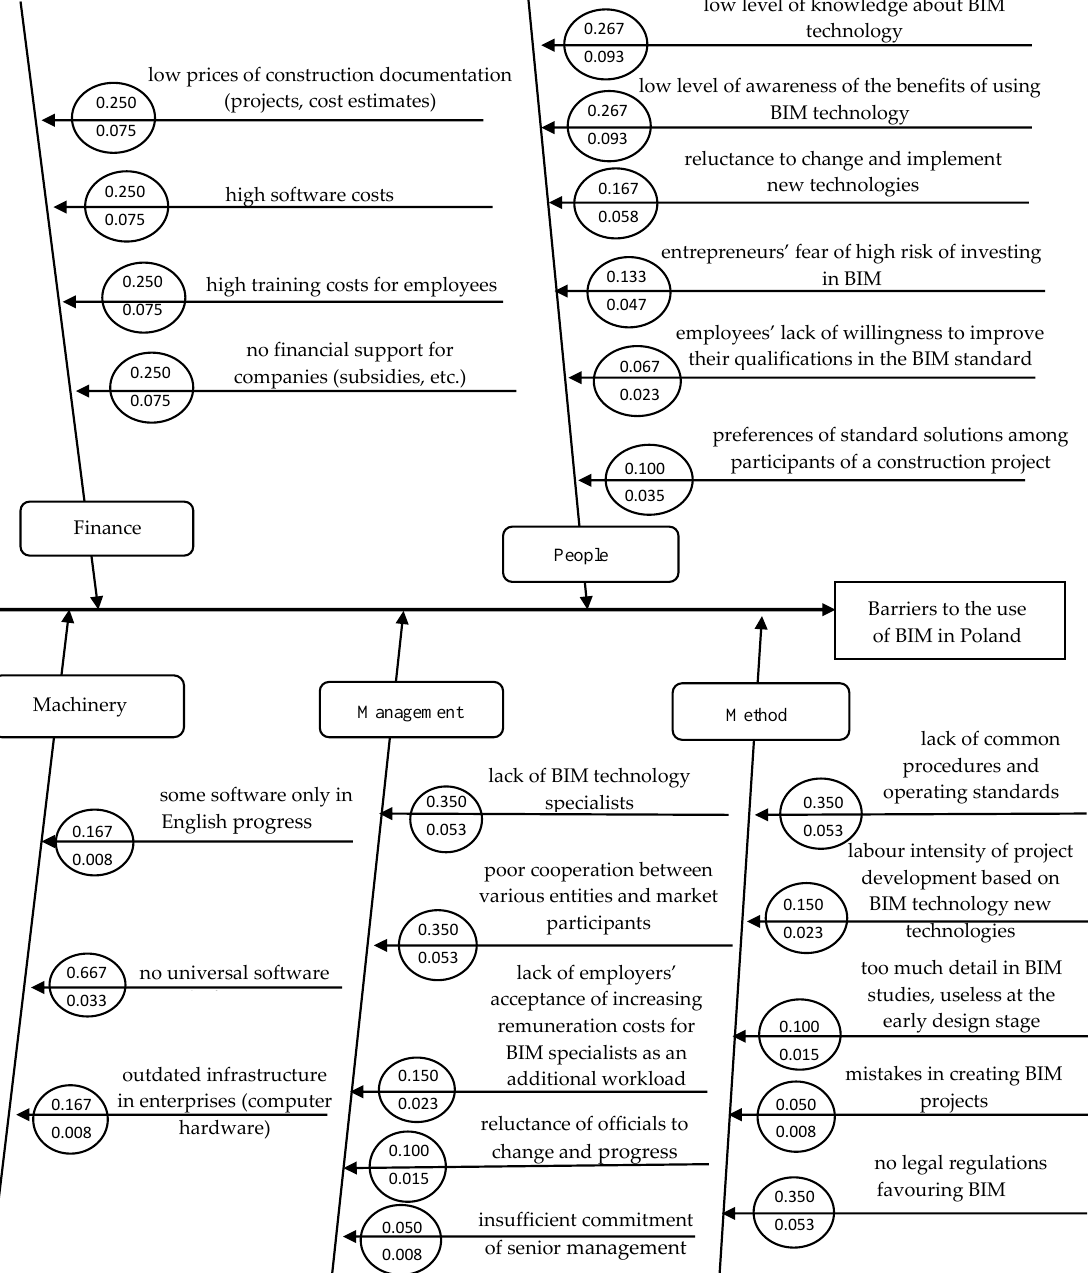
Figure 9. Ishikawa diagram: barriers to applying BIM in Poland.